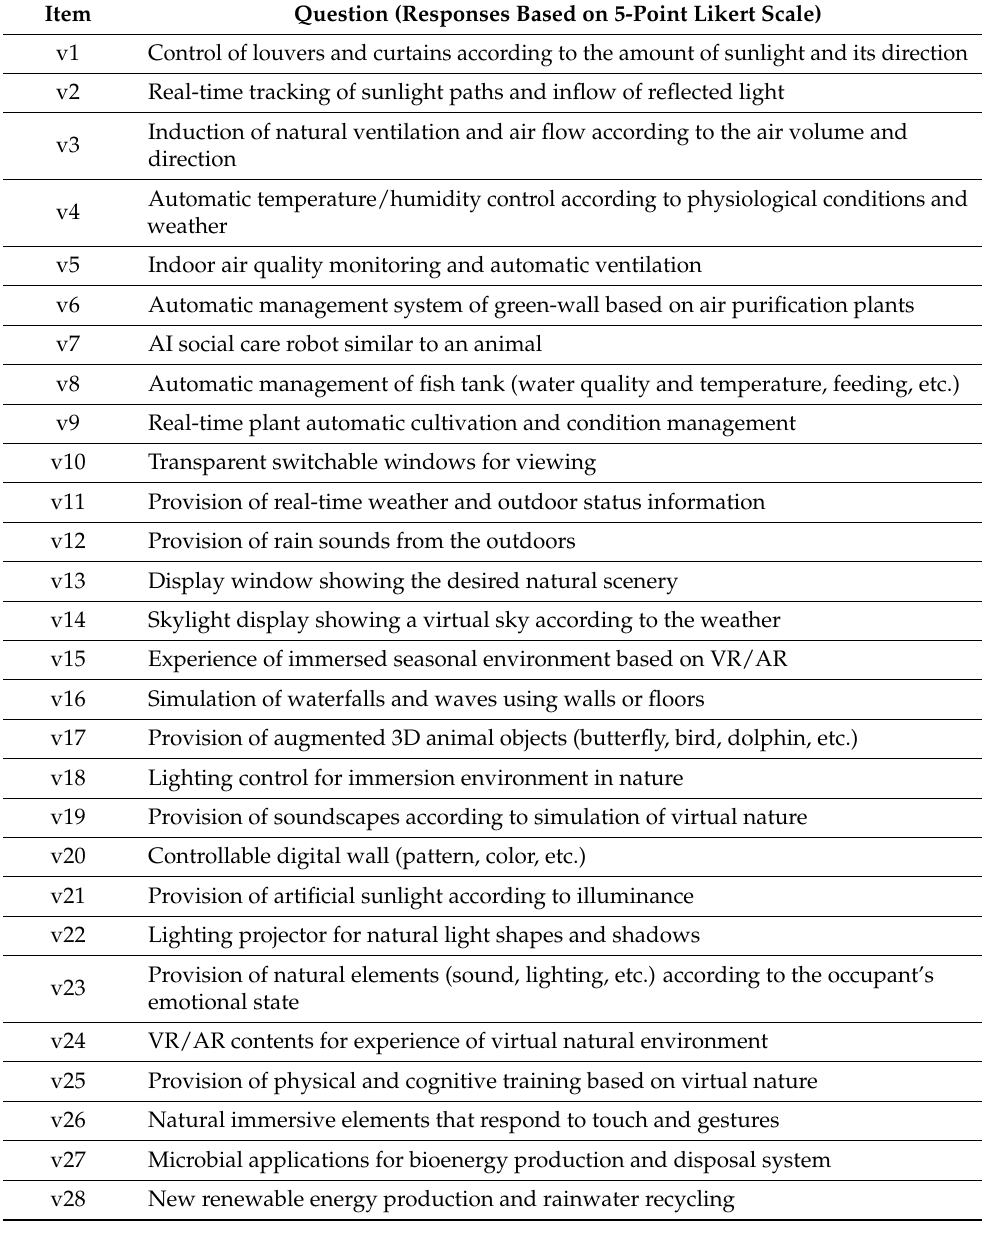
Table A1. Questionnaire details used in the